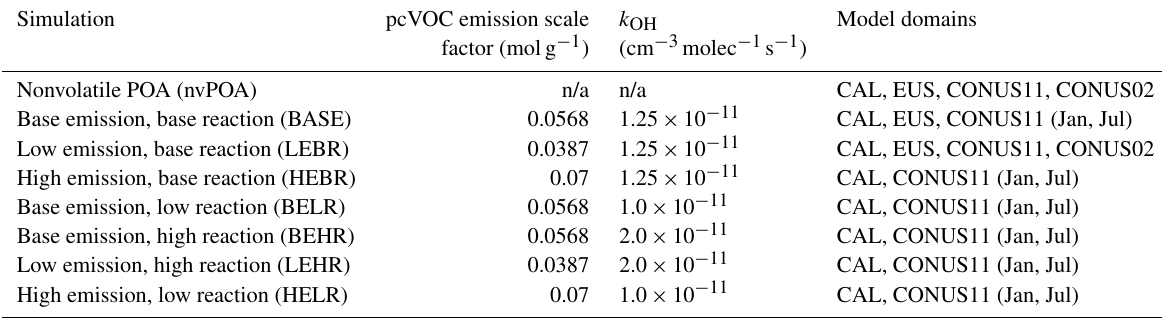
Table 4. Details of base and sensitivity simulation exploring pcSOA formation parameters.